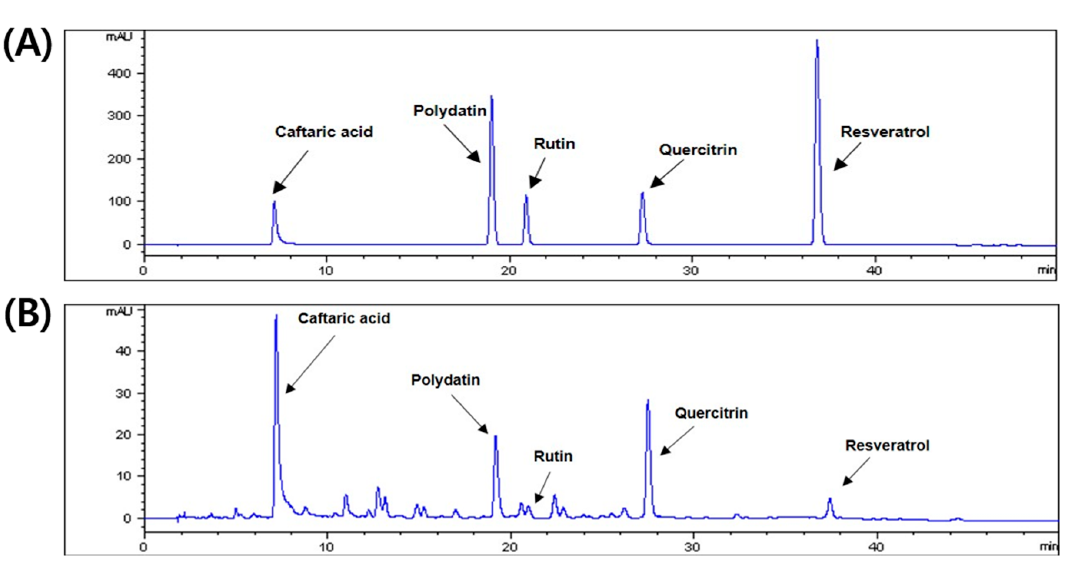
Figure 1. high-performance liquid chromatography (HPLC) chromatogram of Polygonum cuspidatum aqueous extract. ( A ) The five standard components and ( B ) aqueous extract of P. cuspidatum at 330 nm.